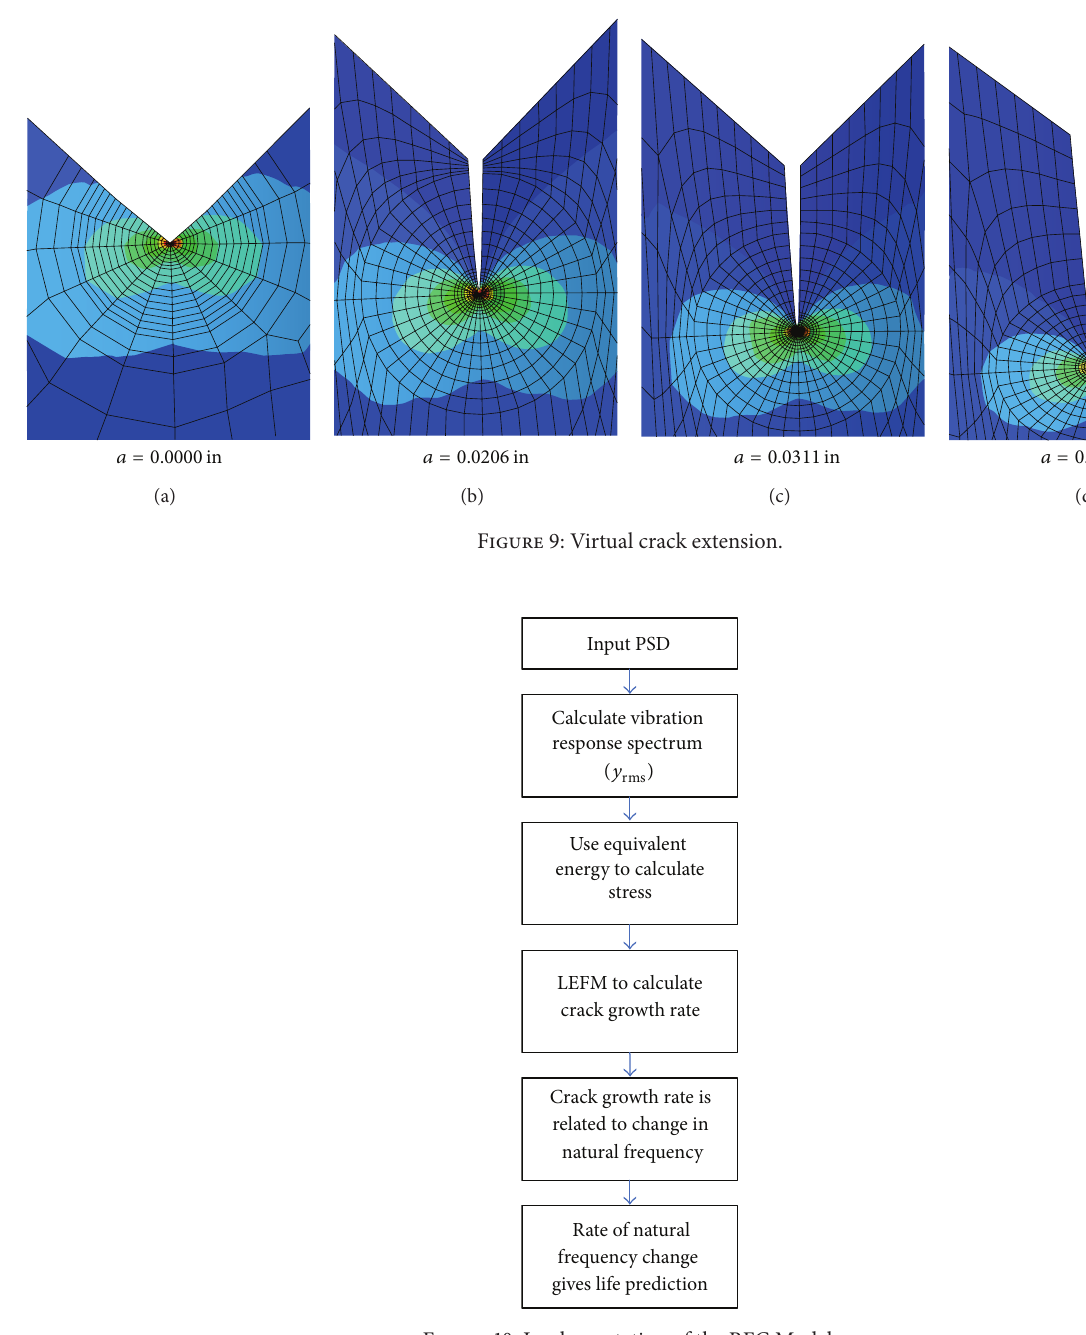
Figure 10: Implementation of the RFC Model.